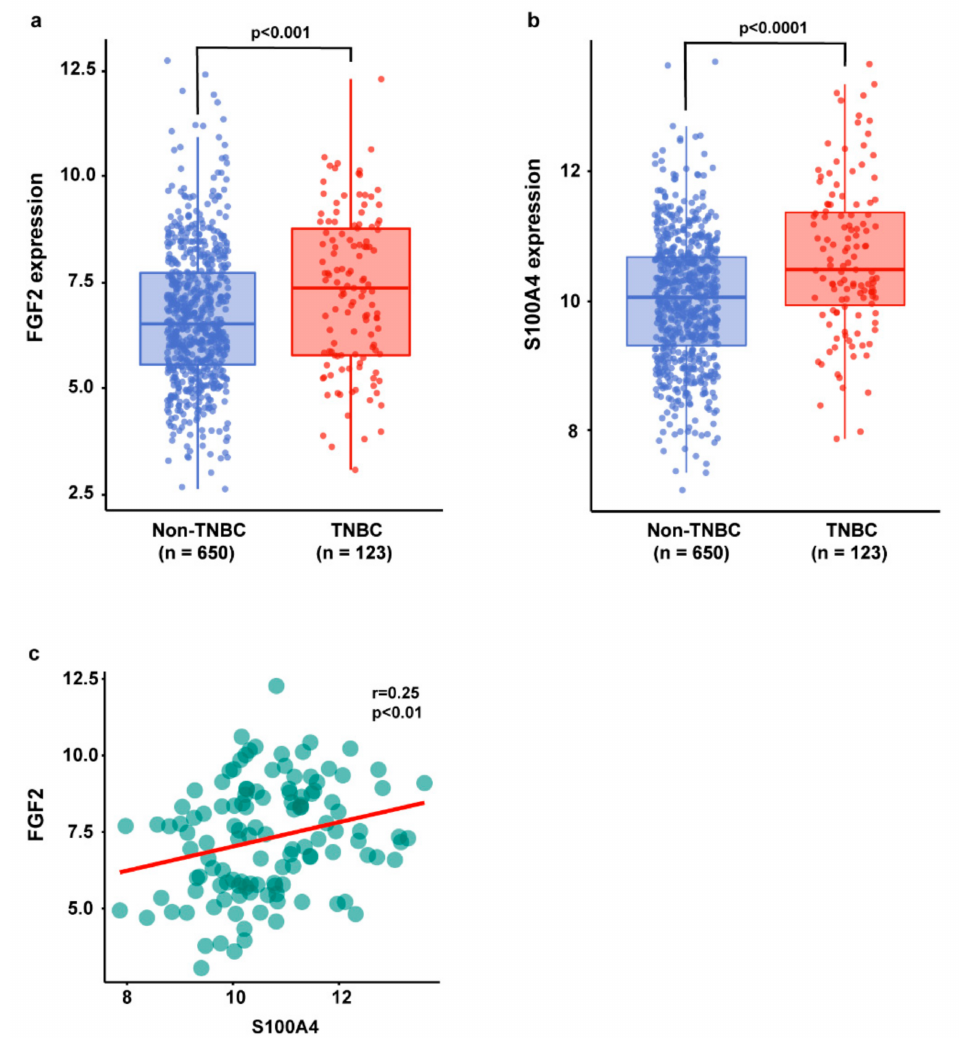
Figure 1. FGF2 and S100A4 gene expression levels in TCGA dataset. Box plots showing the differential expression of FGF2 ( a ) and S100A4 ( b ) in non-TNBC and TNBC patients. ( c ) Scatter plot depicting the correlation between the expression of FGF2 and S100A4 in TNBC samples of the TCGA cohort. The number of patients and p -values are reported in each